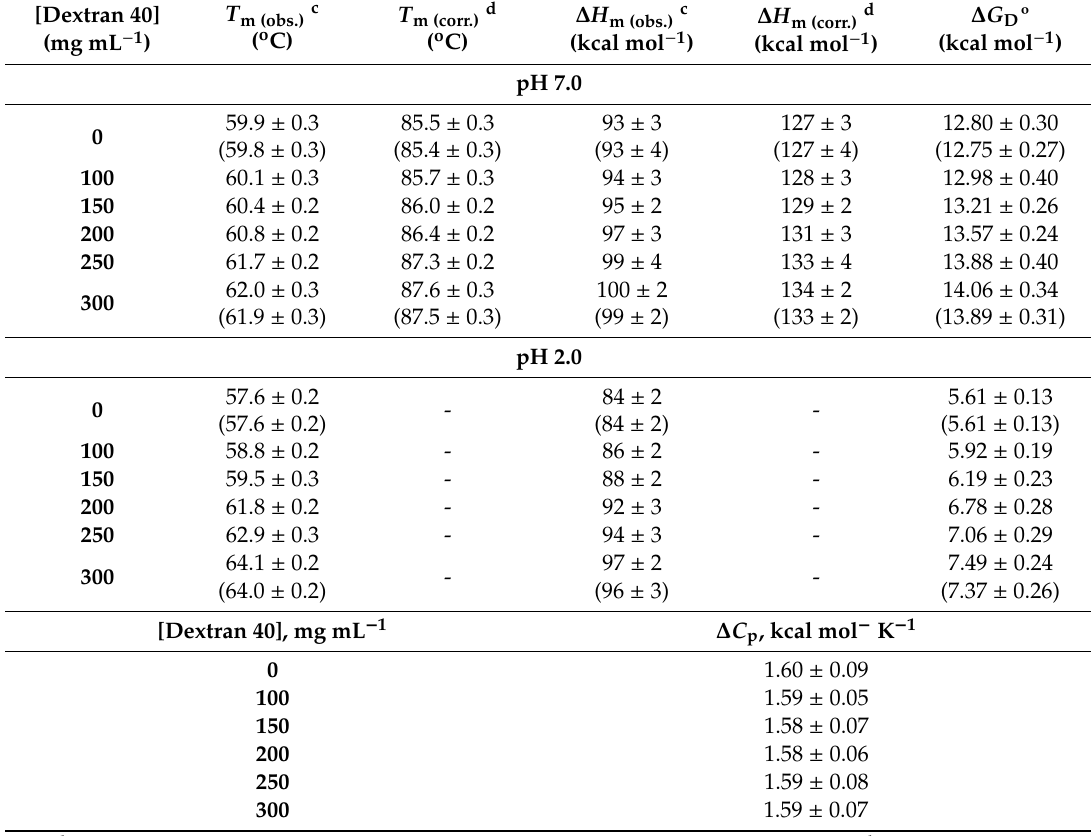
Table 2. Thermodynamic parameters associated with the thermal denaturation of lysozyme in the absence and presence of varying concentrations of dextran 40 at pH 7.0 and 2.0 a,b .